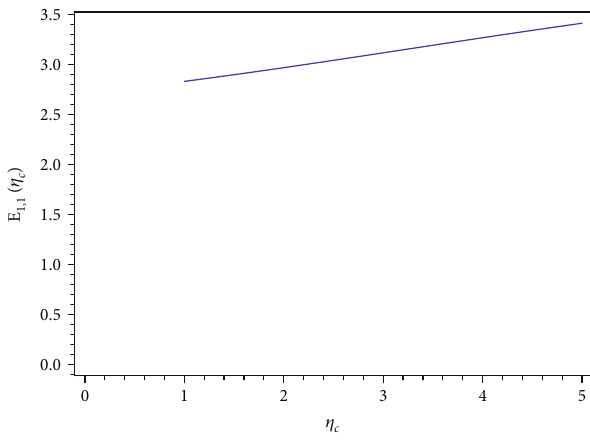
Figure 6: n = l = k = q = a = b = M = 1 , α = 0 : 5 , ω = 0 : 5 , Φ =